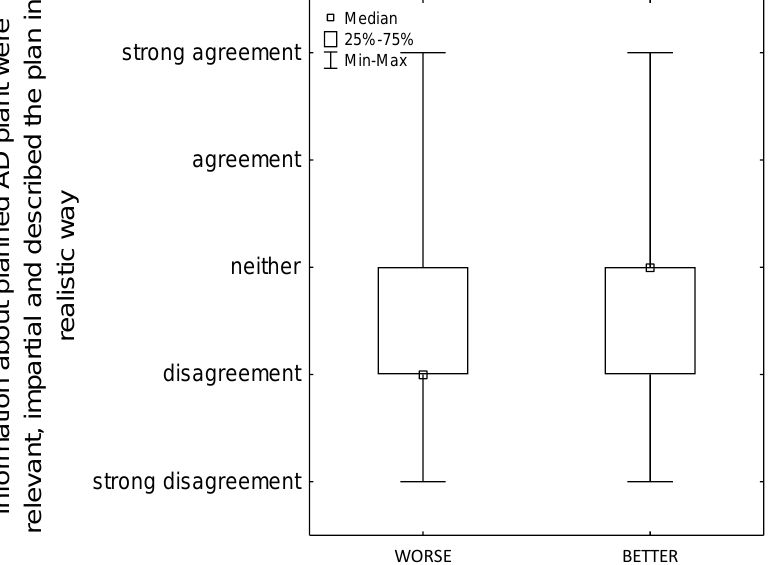
Figure 4. The perception of the relevance and completeness of the presentation of the AD plan in a realistic way.